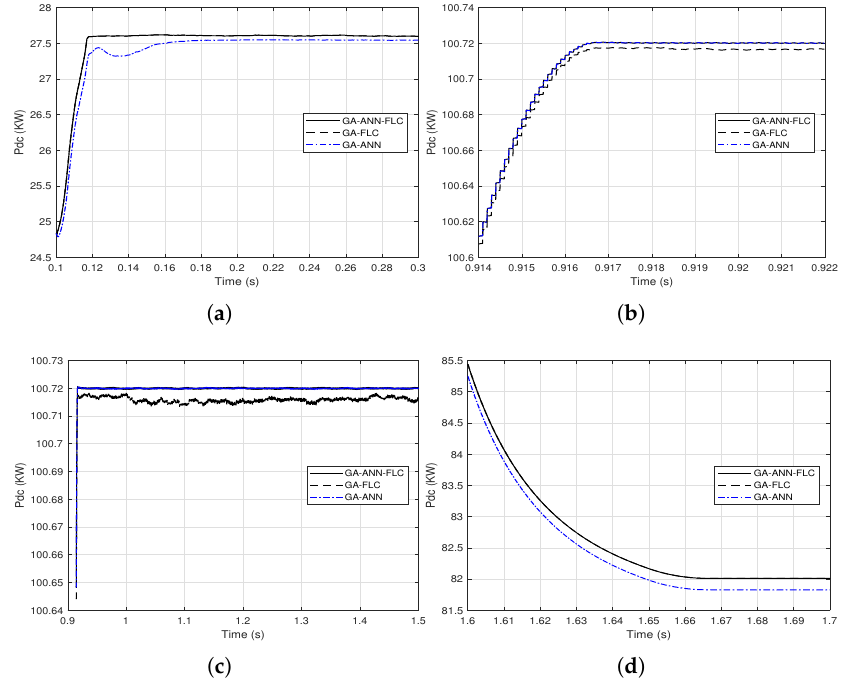
Figure 16. Close views of combining the output DC power response from the GA-FLC and the GA- ANN based MPPT methods based on the environmental conditions G and T c for their linear variations: ( a ) from 0.1 to 0.3 s; ( b ) from 0.914 to 0.922 s; ( c ) from 0.9 to 1.5 s; ( d ) from 1.6 to 1.7